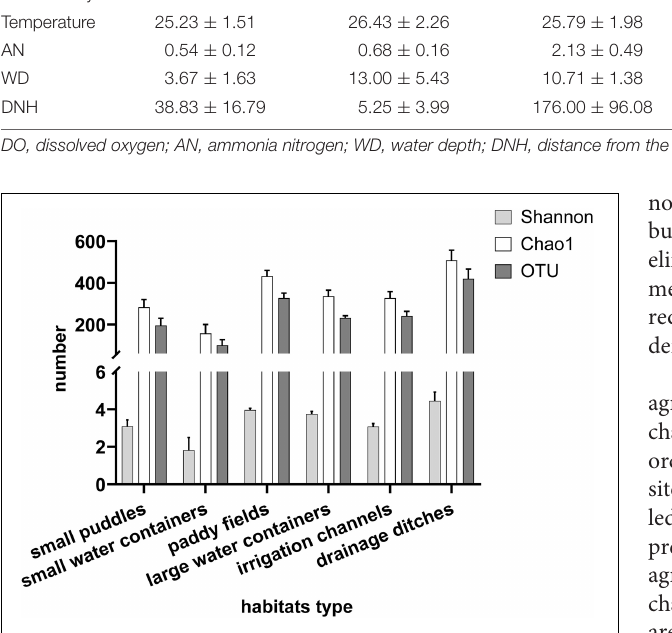
FIGURE 3 | Mean and standard error of the OTU, Shannon Index, and Chao 1 of the 6 habitat types. Shannon index is the bacterial diversity index used to measure species diversity, which was affected by species richness and community evenness in the sample. Chao 1 is the richness index, representing the number of